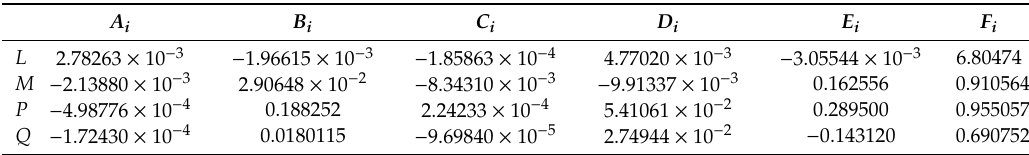
Table 6. Updated coefficients for L , M , P and Q.